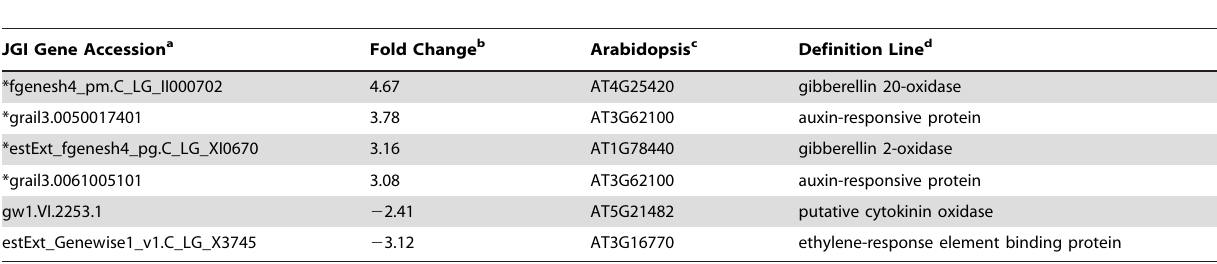
Table 2. Genes up or down-regulated in PCN transgenics involved in hormone related processes.